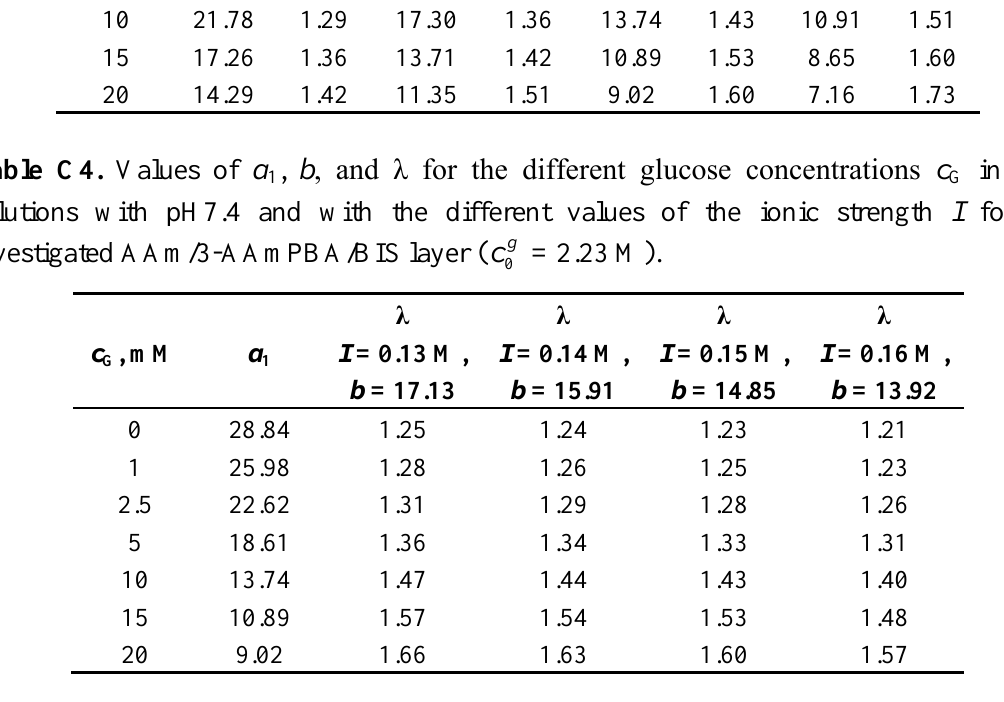
in PBS solutions G